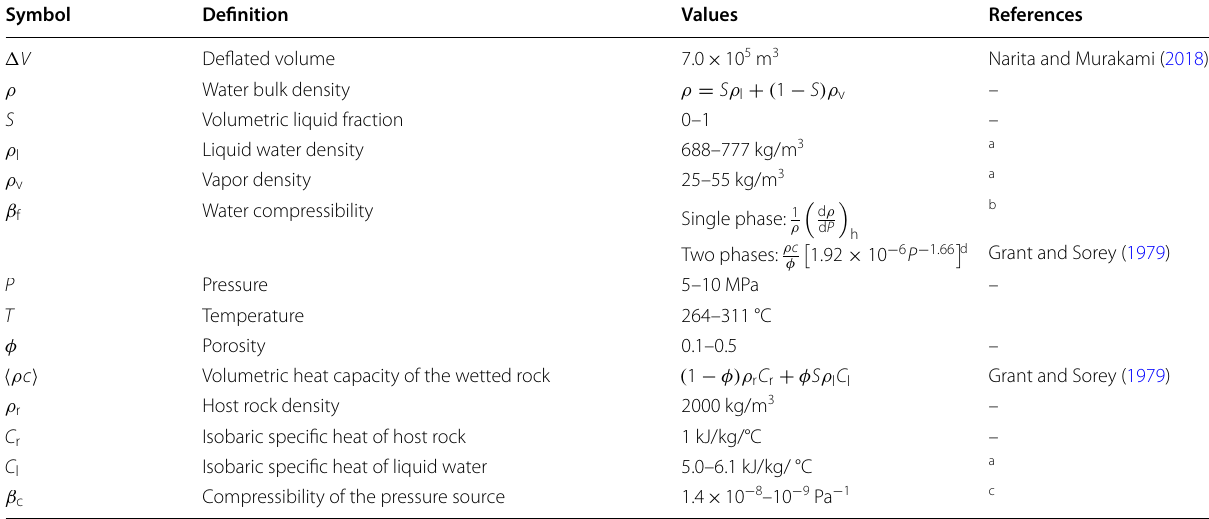
Table 3 Symbols and descriptions of thermodynamic parameters used in this study